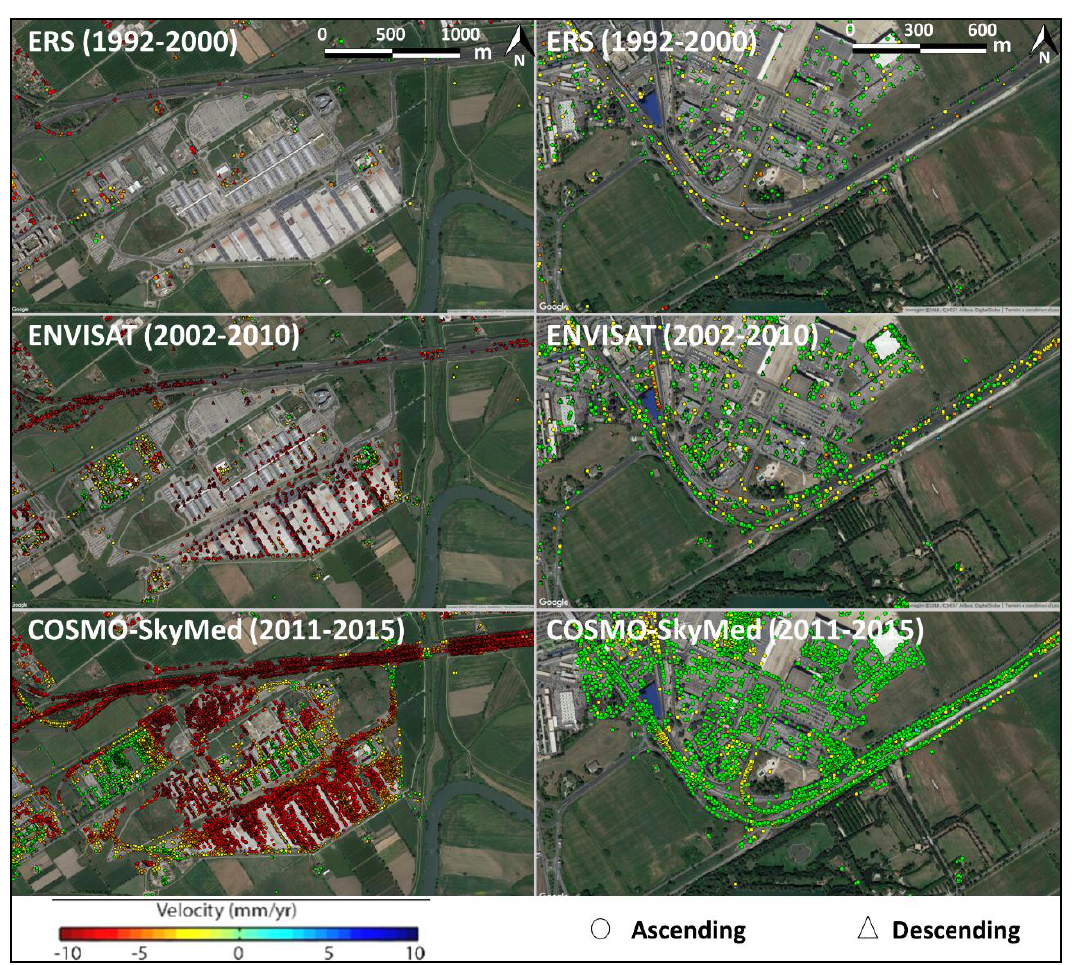
Figure 9 . Velocities of persistent scatterers for the inner ( left column ; sector 1 in Figure 6f) and outer delta ( right column , sector 2 in Figure 6f) regions.